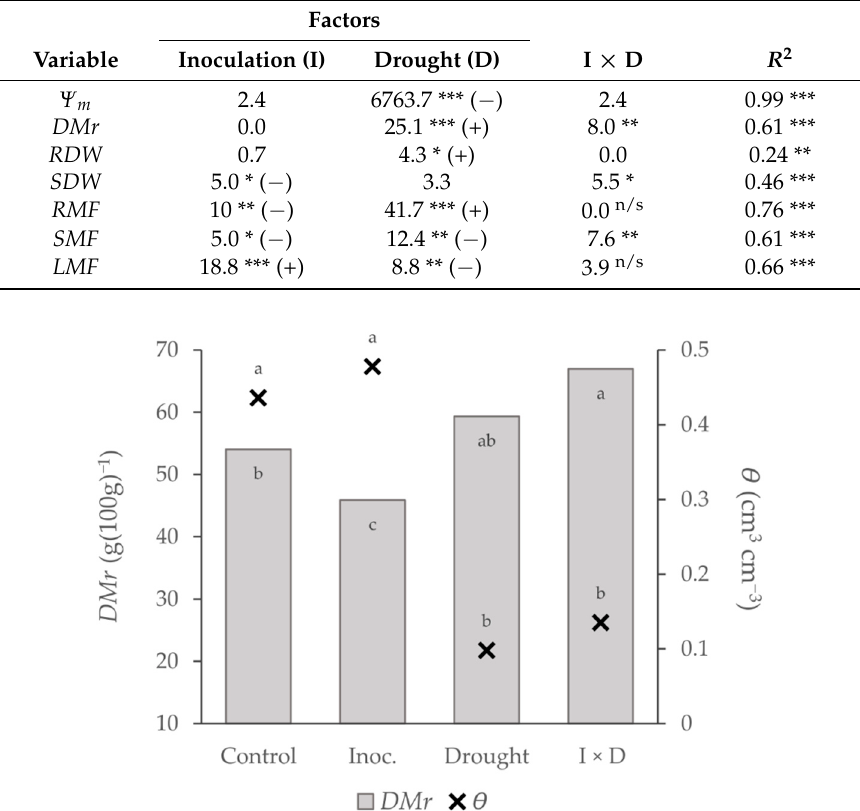
Figure 3. Mean volumetric water content ( θ ) of soil (points) and mean dry matter of roots (columns) at 30 dpi. Treatments with the same letter for each variable are not significantly different ( p > 0.05).